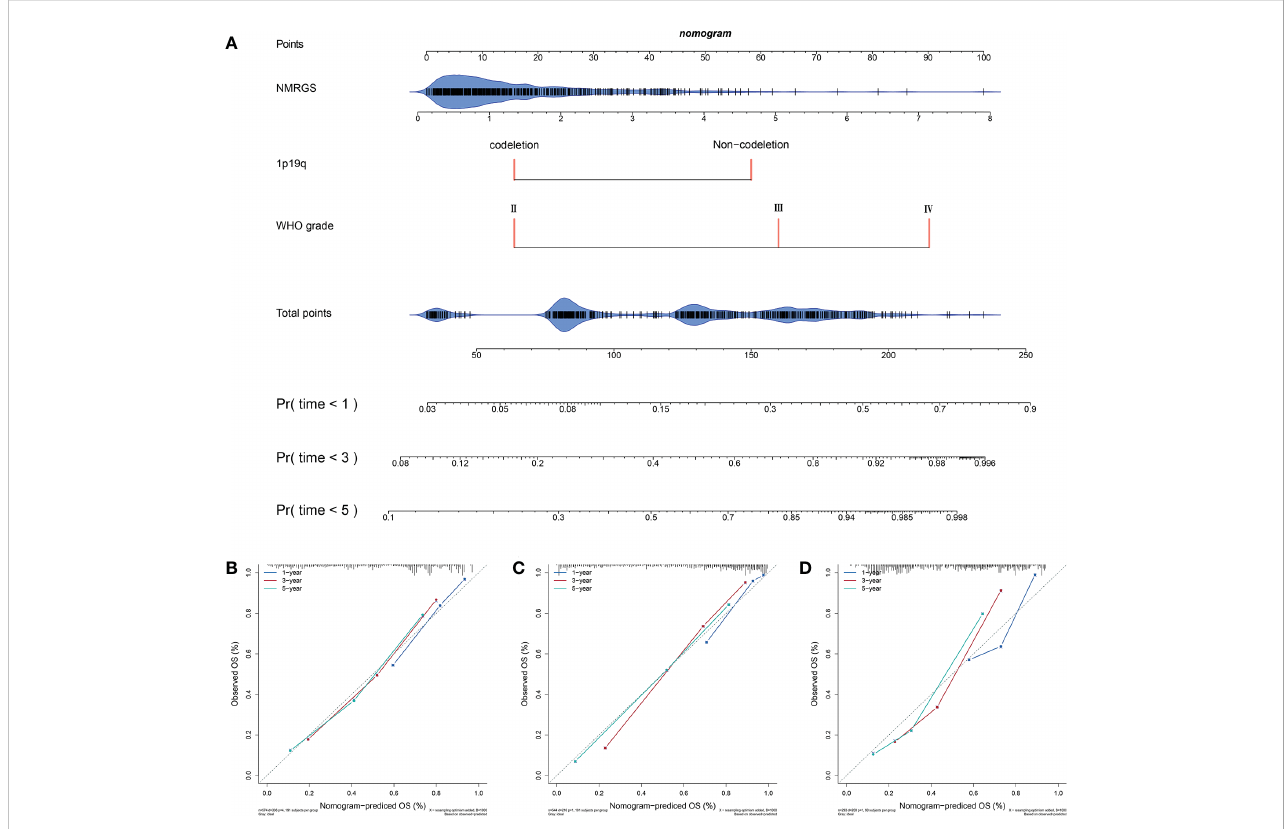
FIGURE 5 Construction and evaluation of a nomogram. (A) A nomogram was constructed based on the independent risk factors (NMRGS score, 1p19q codeletion status, and WHO grade) in CGGA693 cohort. (B – D) Calibration curves showing the concordance between the actual and nomogram-predicted 1-, 3-, and 5-year overall survival in CGGA693, TCGA, and CGGA325